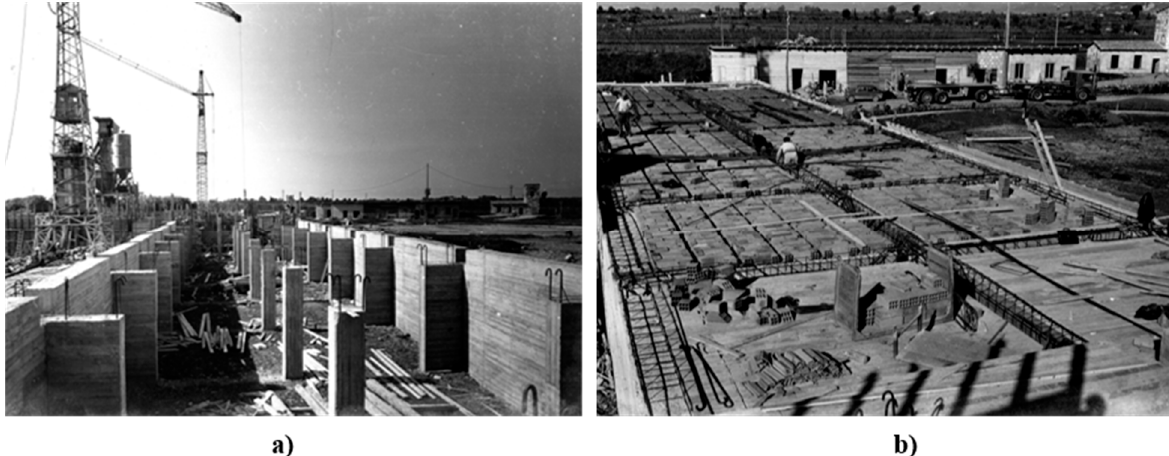
Figure 6. Archive photos of the Reinforced Concrete (RC) box at the basement: ( a ) before and ( b ) after the realization of the slab (note that the clay blocks, with which the slab is made, are clearly visible).